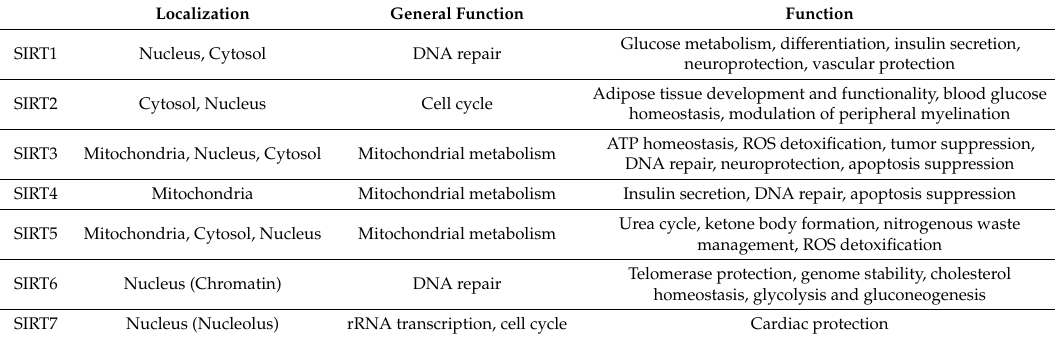
Figure 2. Activation of the NMRK2 pathway represent a common adaptive mechanism in the failing heart where NAD + levels are low. NAD + synthesis from NR through the NMRK2 pathway may be favored, as the NMN synthesis from NR by NMRK enzymes requires only one ATP molecule while synthesis from NAM by NAMPT requires at least three ATP equivalents. Table 1. Central role of sirtuins in DNA repair, cell cycle control and mitochondria function (adapted from Meng et al.